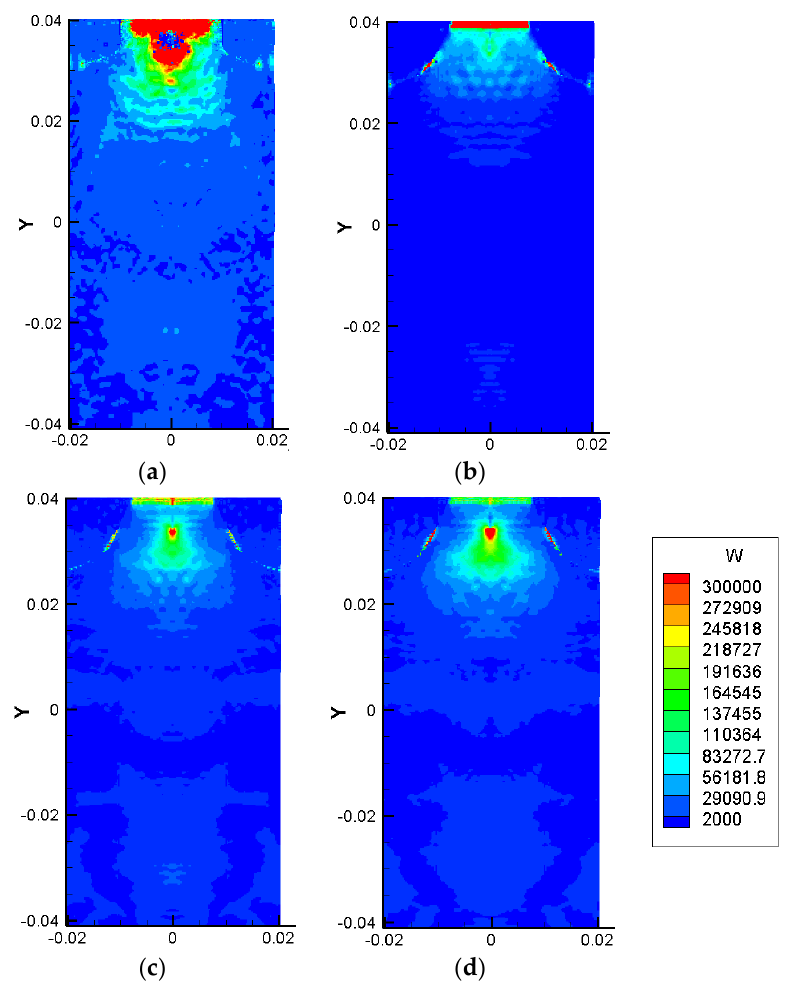
Figure 13. Contours of elastic energy density in the FGM coating with the elastic ratio at 100 µs: ( a ) E 2 / E 1 = 0.5; ( b ) E 2 / E 1 = 2.5; ( c ) E 2 / E 1 = 5; ( d ) E 2 / E 1 = 10.